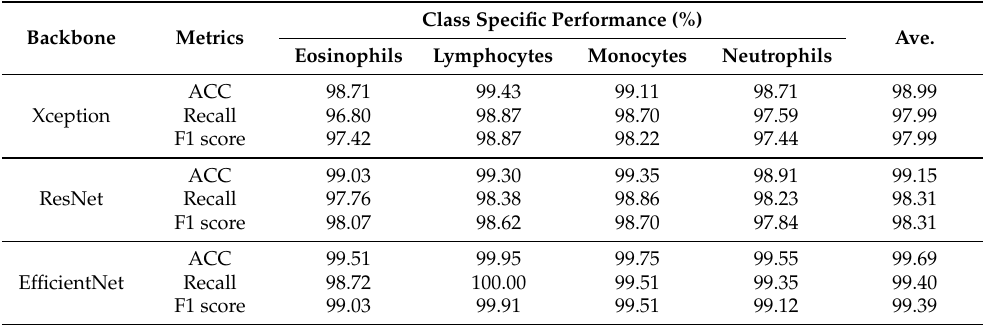
Table 3. Comparison of classification performance from three CNN backbones. The best performance was achieved using EfficientNet as the backbone with 99.69 % accuracy.